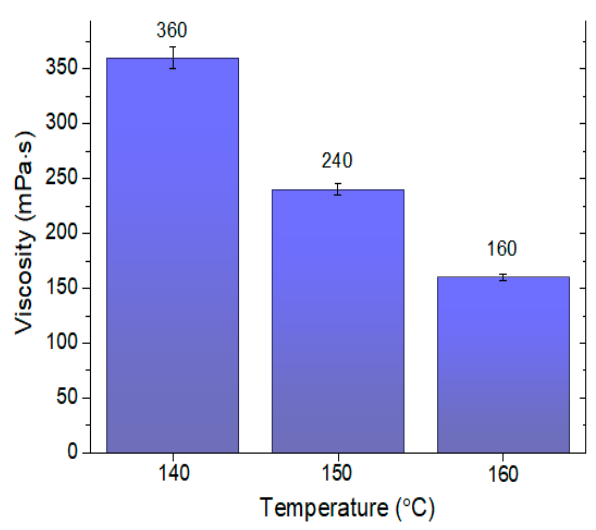
/ 70 road asphalt.